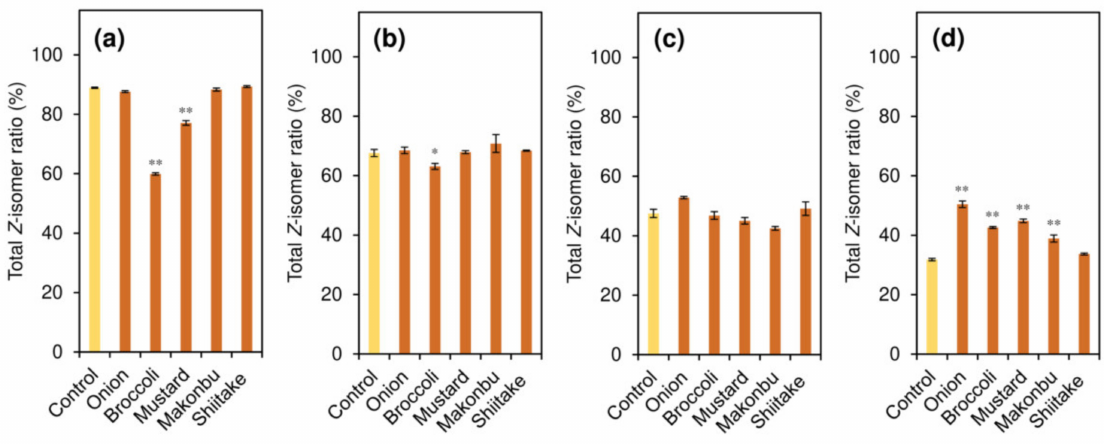
Figure 5. Effects of extraction solvents and foodstuffs on the total Z -isomer ratio of lycopene in the extract. The foodstuffs were added to the extraction process and ( a ) ethanol, ( b ) 2-propanol, ( c ) acetone, and ( d ) ethyl acetate were used as extraction solvents. Error bars represent mean ± standard deviation ( n = 3). Asterisks (*) indicate a statistically significant difference from the control group (* p < 0.05, ** p < 0.01, Dunnett’s t